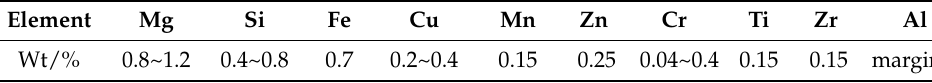
Figure 8. Macroscopic surface coating. Table 6. Chemical composition of 6061 aluminum alloy.